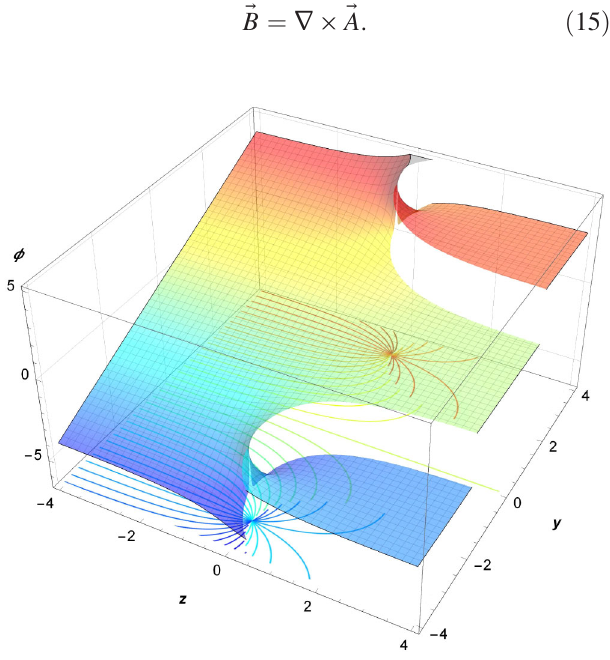
FIG. 2. Scalar potential φ in the fringe field region of a dipole magnet. The field has a falloff in the plane y ¼ 0 described by a single-parameterEngefunction,thecontoursofconstant φ showing possible pole-face